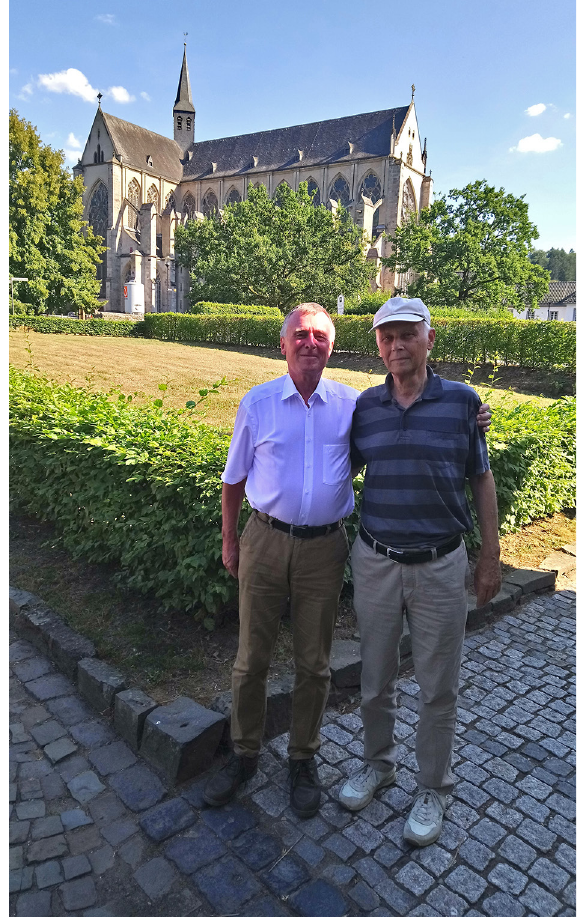
Photo 1. Professor Eike W. Schamp (right) with